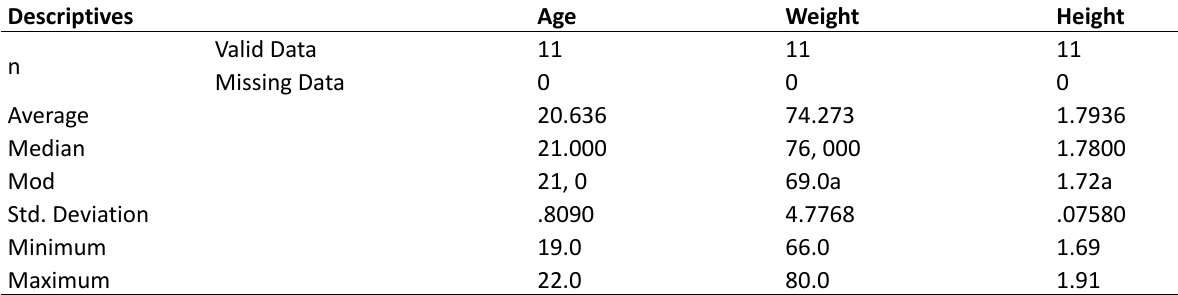
Table 3: Wilcoxon Signed Rank Analysis Results of Placebo Application (The Hoff Test) Mathematical